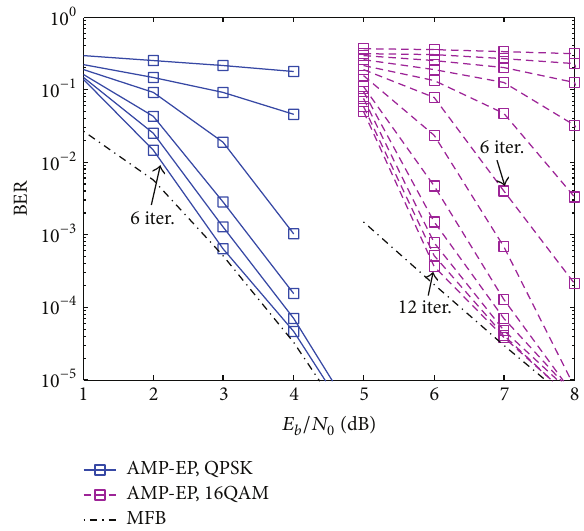
Figure 6: BER performance versus 𝐸 𝑏 / 𝑁 0 for the AMP-EP algo- rithm with different number of iterations in a 64 × 64 MIMO system with QPSK and 16QAM modulation. 16-tap Rayleigh channel with equal tap